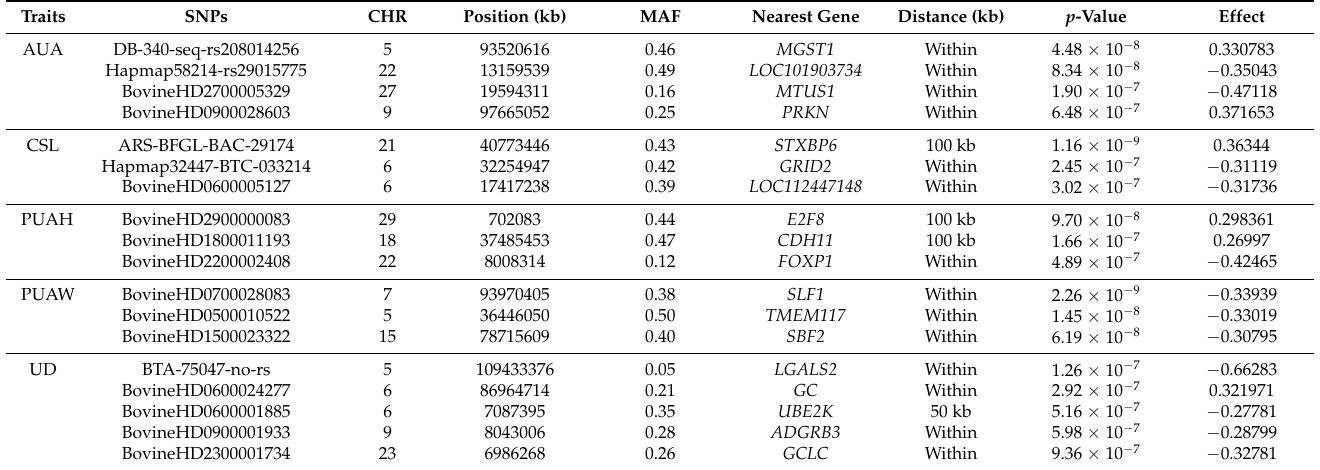
Table 3. GWAS significant SNPs associated with udder structure conformation traits in Holstein